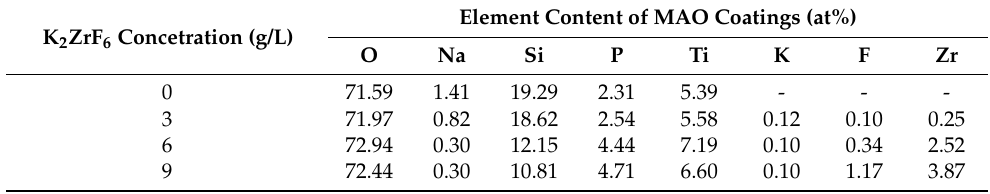
Table 1. Element content of MAO coatings prepared under different K 2 ZrF 6 concentrations.